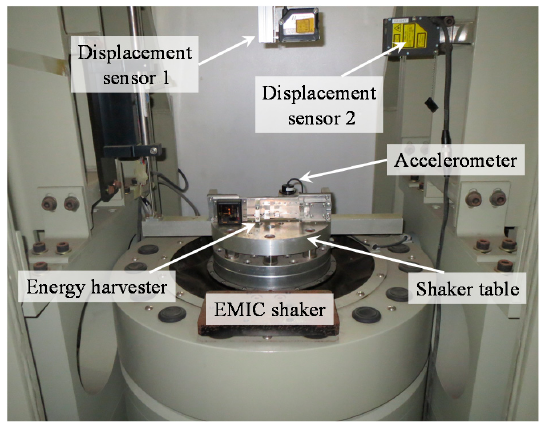
Figure 6. Overview setting of experiment apparatus.